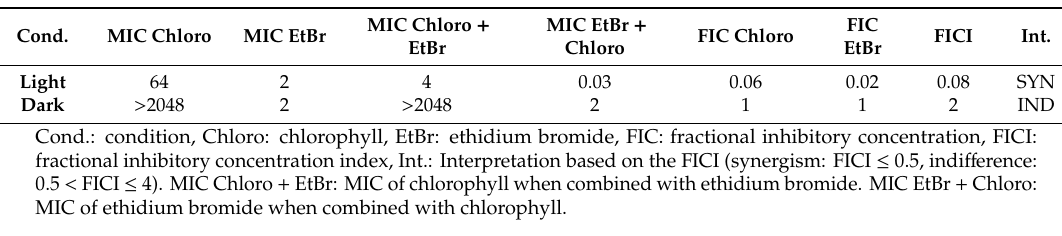
Table 4. Results of the combinations assays using ethidium bromide and chlorophyll against MRSA NCTC 10442. All values are given in µ g /